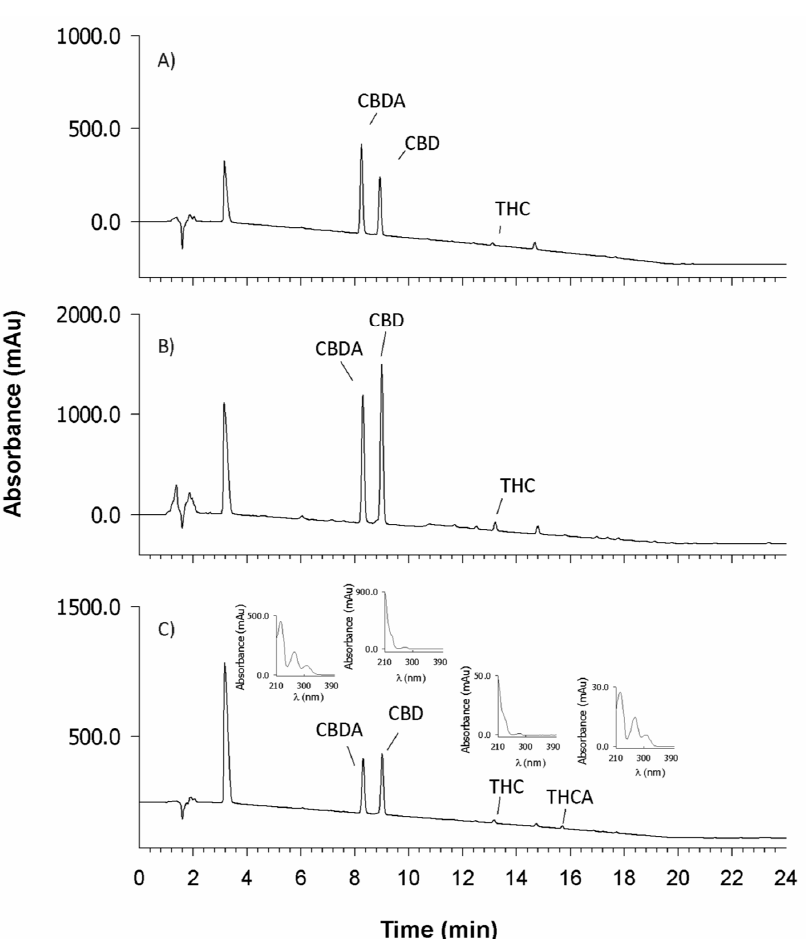
Figure 2. HPLC-UV chromatographic profile of an extract of cannabis inflorescences at 220 nm: ( A